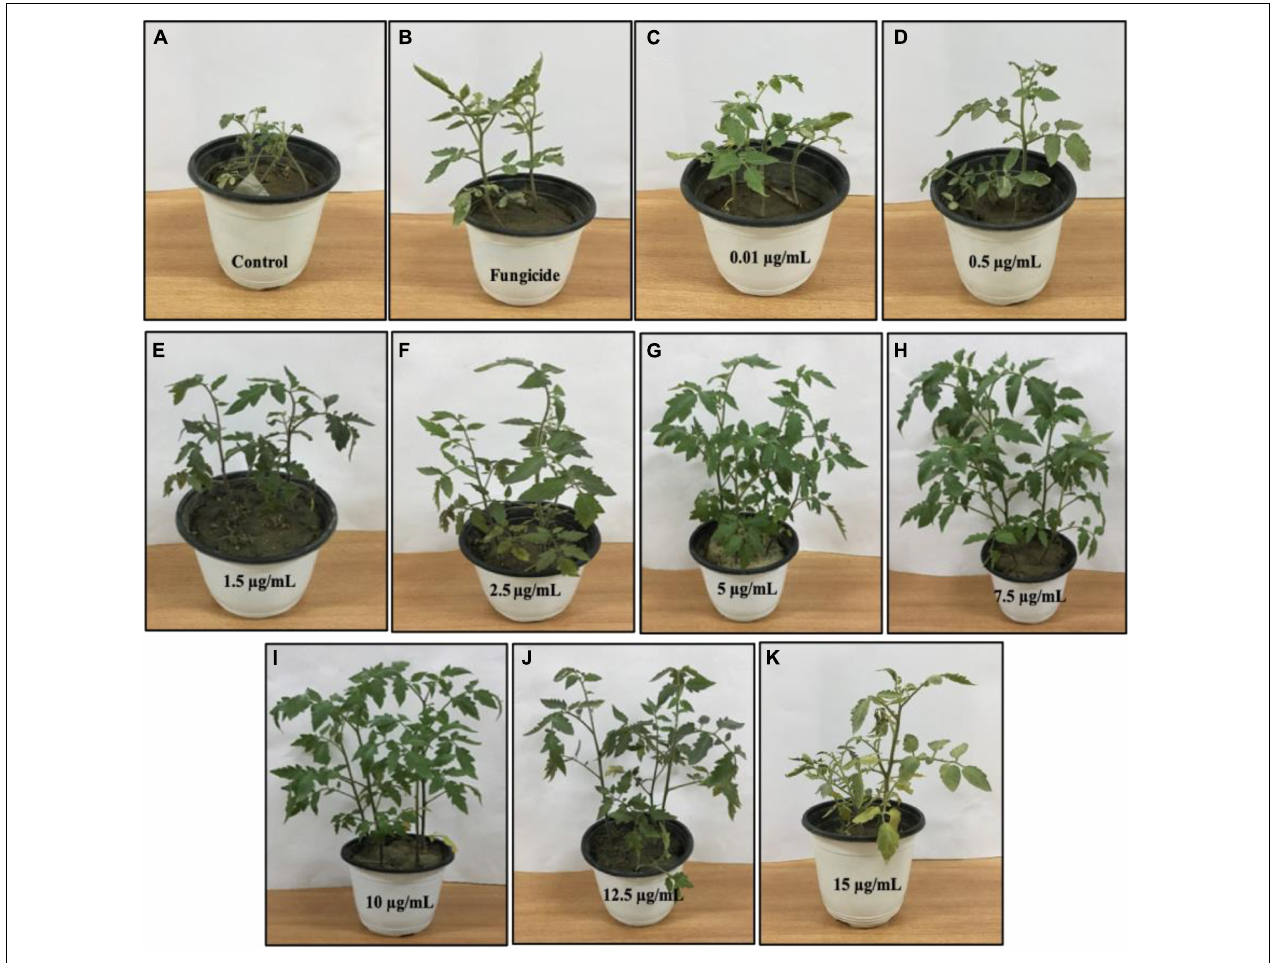
FIGURE 12 | Effect of various concentrations of BC-Fe 3 O 4 NPs on infected tomato plants under greenhouse pot experiment. (A) Pathogen-control, (B) non-pathogen control, (C–K) different concentrations (0.01, 0.5, 1.5, 2.5, 5, 7.5, 10, 12.5, and 15 µ g/ml) of BC-Fe 3 O 4